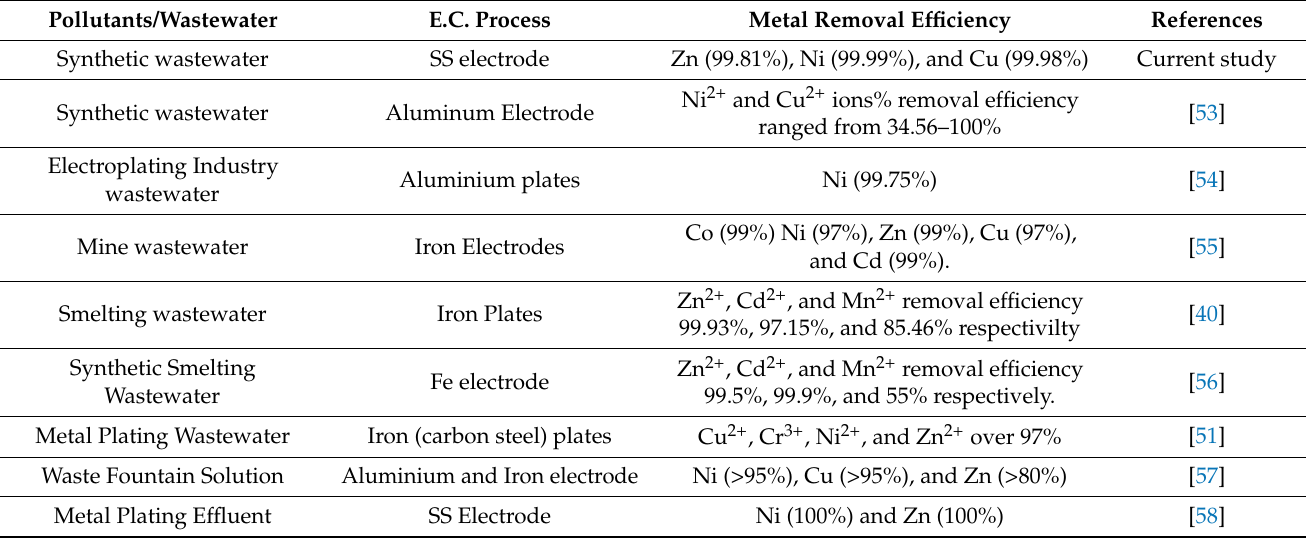
Table 6. Overview of metals ion removal efficiency by EC processes described in the literature.